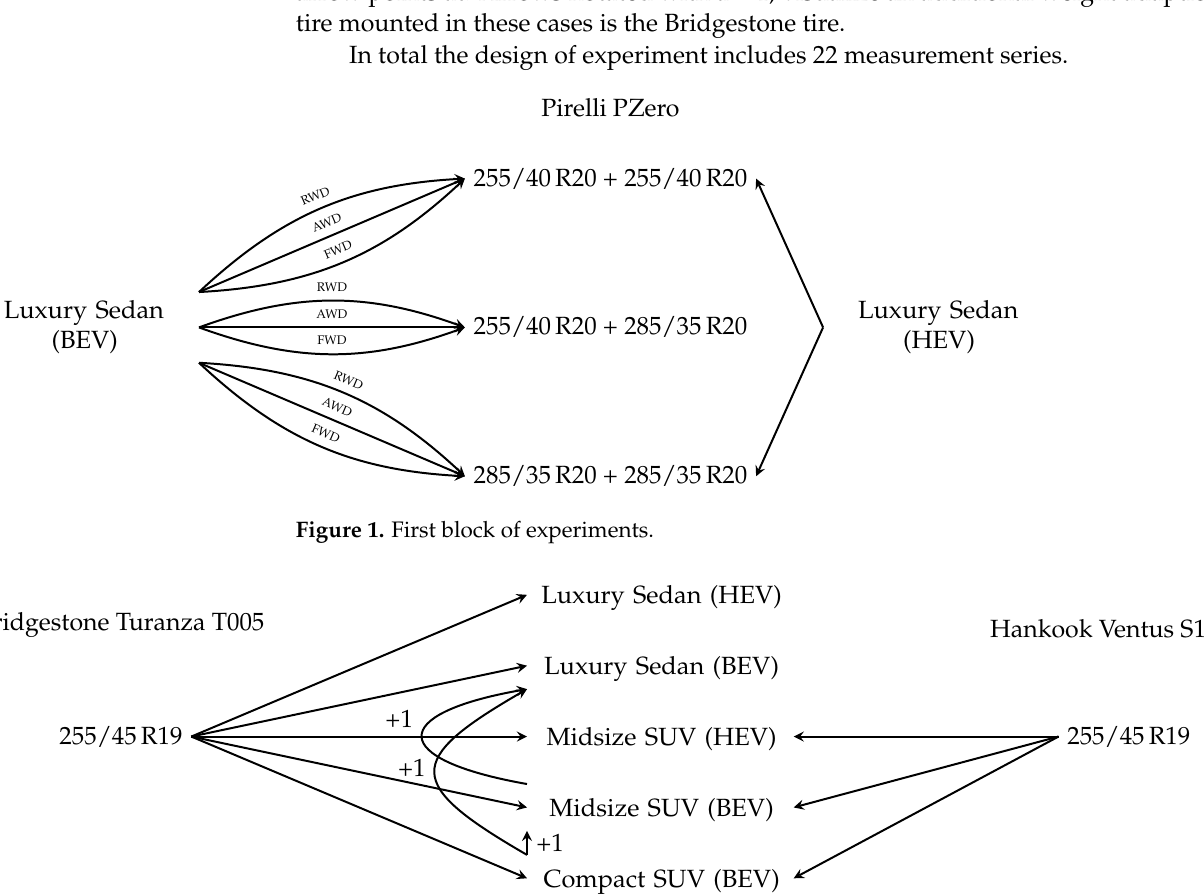
Figure 2. Second block of experiments, +1 indicating an additional weight adaption of the